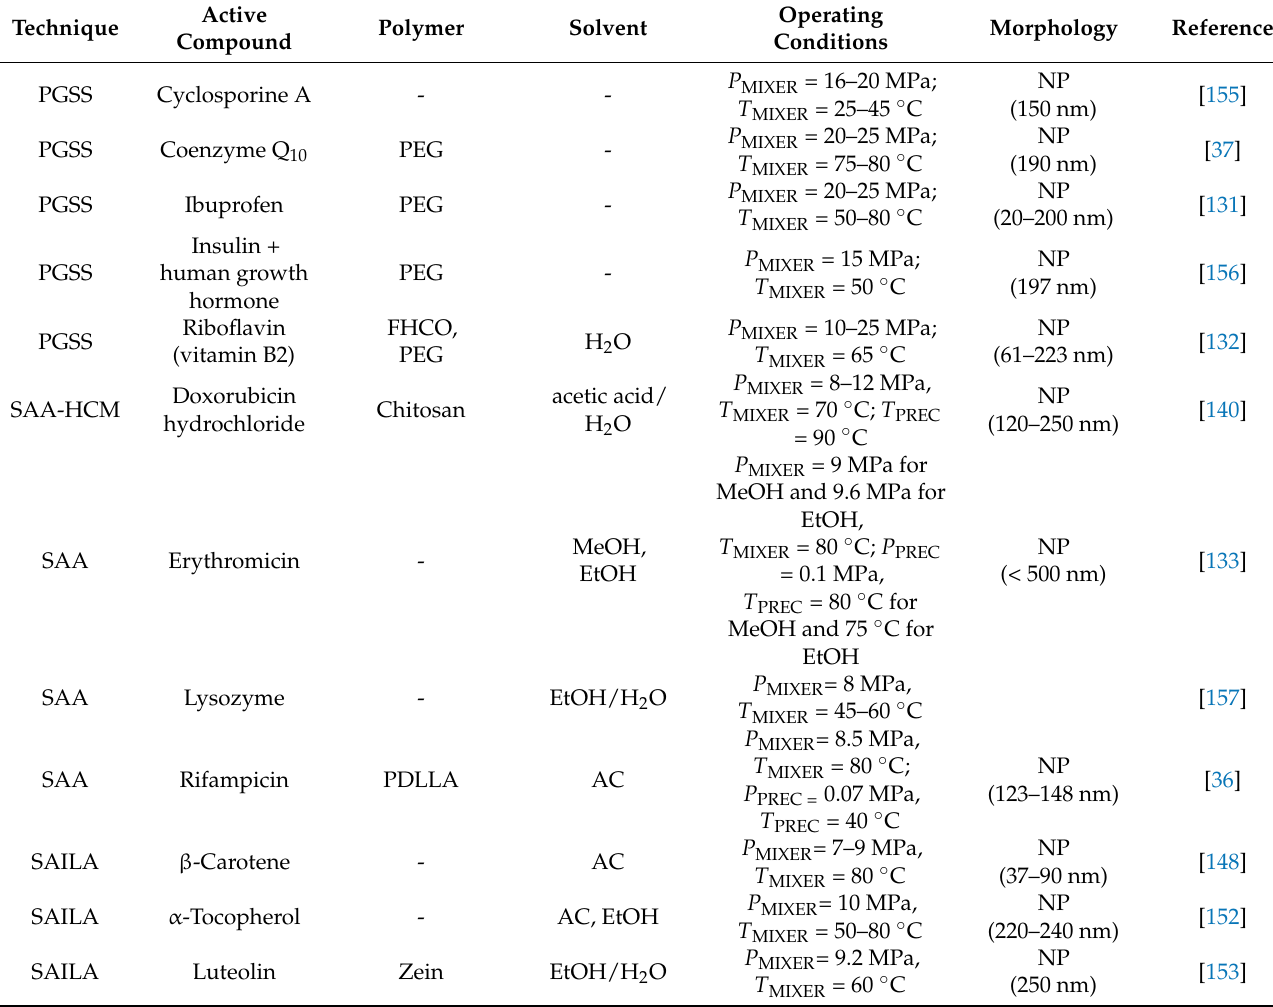
Table 3. An overview of nanoparticle production by using CO 2 as a co-solute. NP: nanoparticles; P MIXER : pressure in the saturator/mixer; P PREC : pressure; T MIXER : temperature in the saturator/mixer; T PREC : precipitator temperature; FHCO: fully hydrogenated canola oil; PDLLA: poly( D , L -lactide); PEG: polyethylene glycol; AC: acetone; EtOH: ethanol;